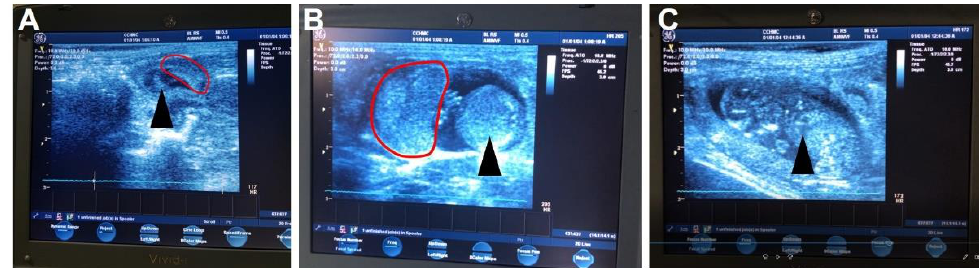
Figure 4. Ultrasound images of the guinea pig pregnancy. The earliest time to reliably detect a guinea pig pregnancy using an ultrasound is approximately gestational day 21, in which the most obvious signs of a fetus are the amniotic cavity and placenta ( A ). By mid-gestation (gestational day 30–35) the placenta and sub-placental region are visible along with the fetus ( B ) including a clear identification of the fetal heart ( C ). The black arrow identifies the developing fetus, pointing to the fetal heart in ( C ). The red outline indicates the placenta.